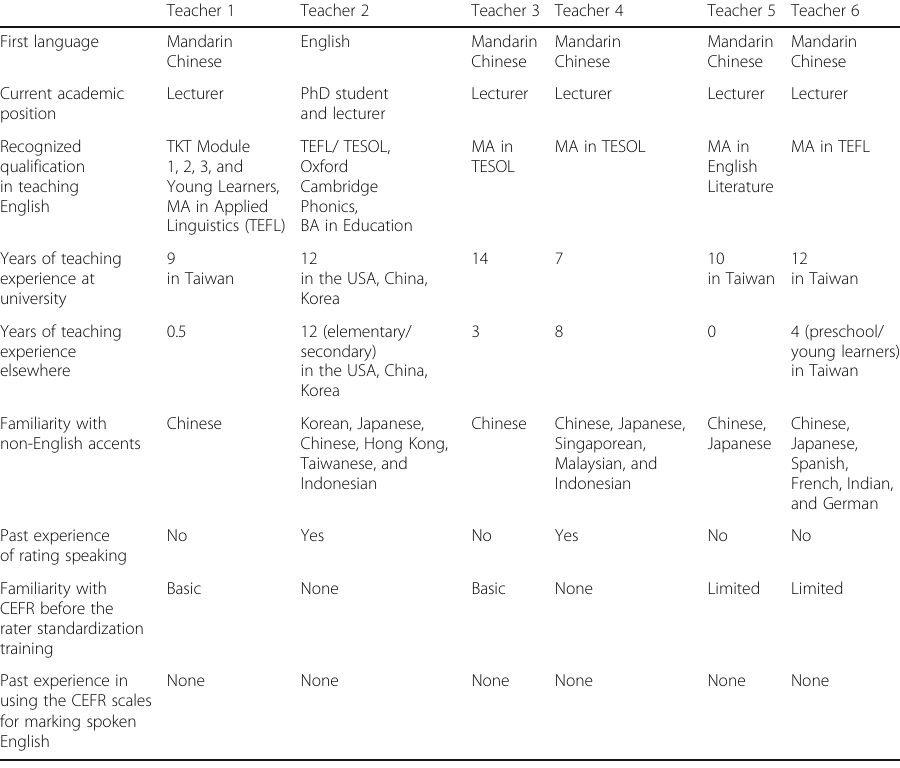
Table 2 Educational background and teaching experience of the teachers of